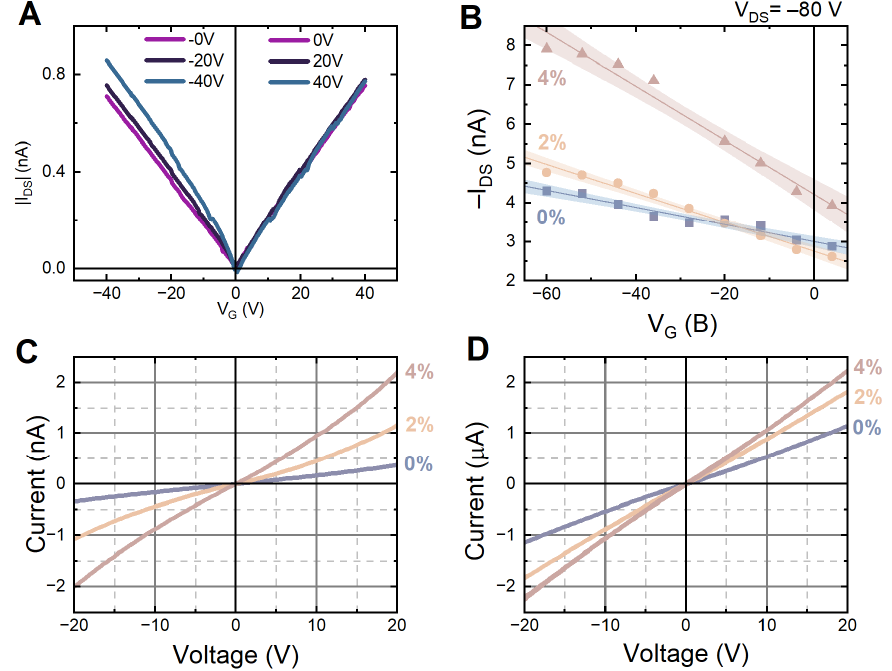
Figure 6. ( A ) Output characteristics I DS ( V DS ) of pristine HgTe-EDT with different V G values, ( B ) Averaged transfer curves of Pb-doped HgTe-EDT NPLs; IV curves of Pb-doped HgTe-EDT NPLs in the dark ( C ) and in the light ( D ).